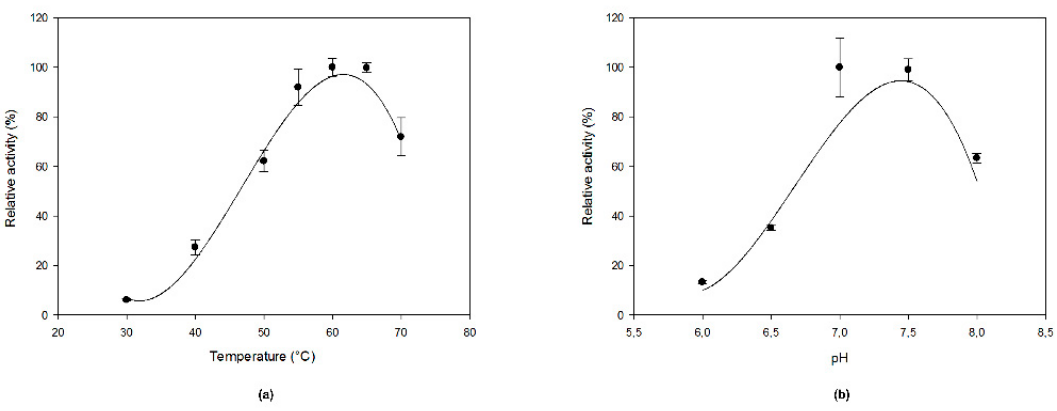
Figure 3. The effect of ( a ) temperature and ( b ) pH on MfGM35E activity. The pH and temperature profiles were determined in the presence of 2 mM GDP-Man at 40 °C and pH 8, respectively.